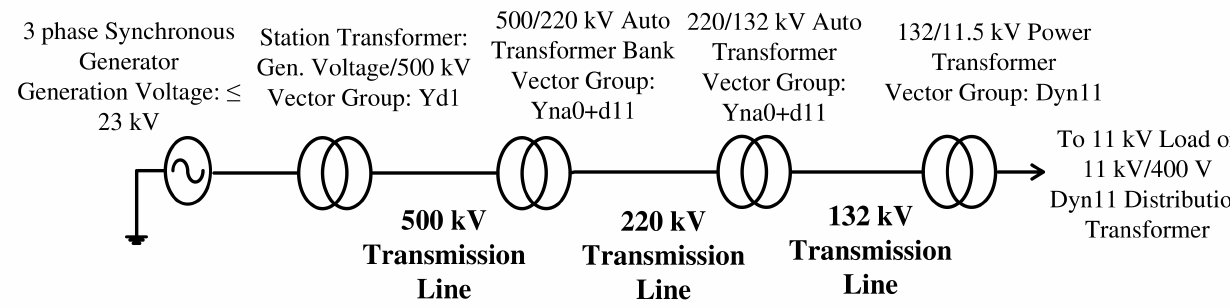
Figure 1. Single line diagram showing all voltage levels of the power system in Pakistan